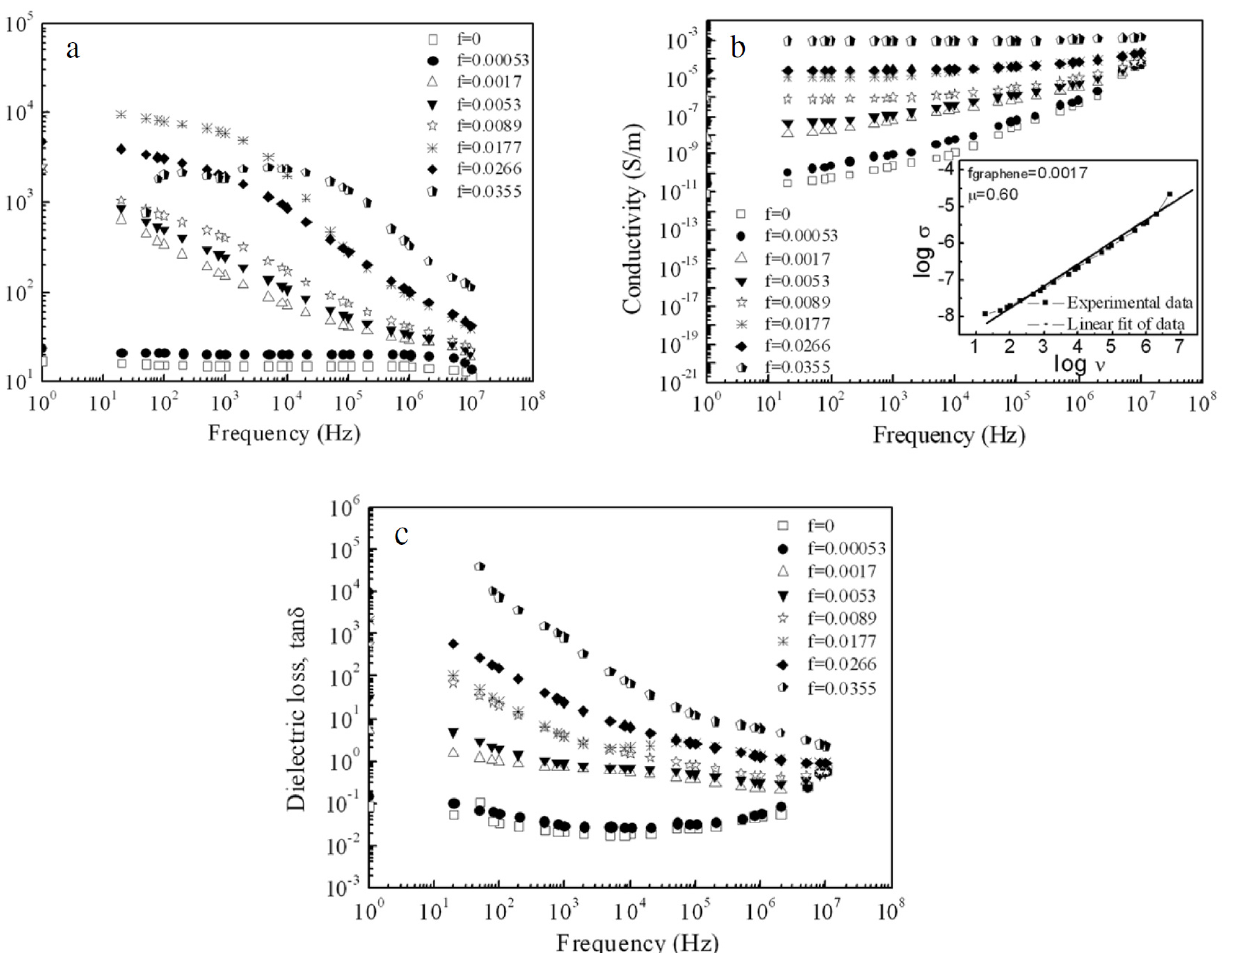
Figure 4. Dependences of ( a ) dielectric constants, ( b ) ac conductivities and ( c ) loss tangent on frequency for the graphene/PVDF composites at room temperature [38].